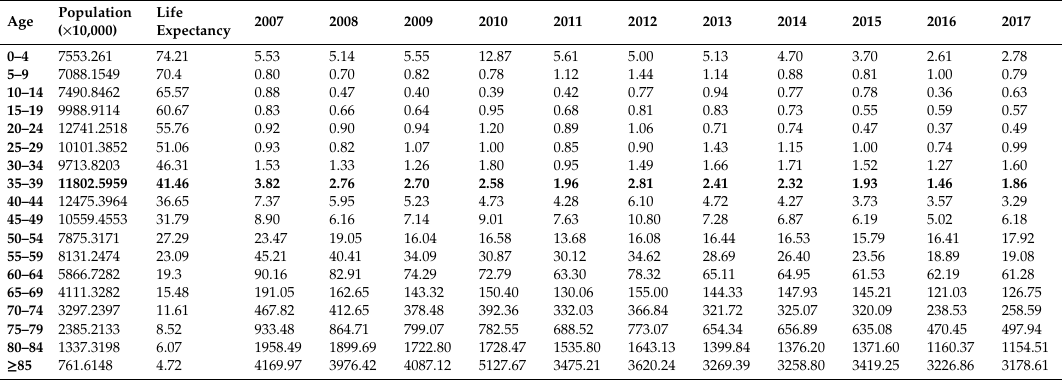
Table A4. Population, life expectancy and respiratory disease mortality (1 / 100,000) of all age groups. Age Population ( × 10,000)